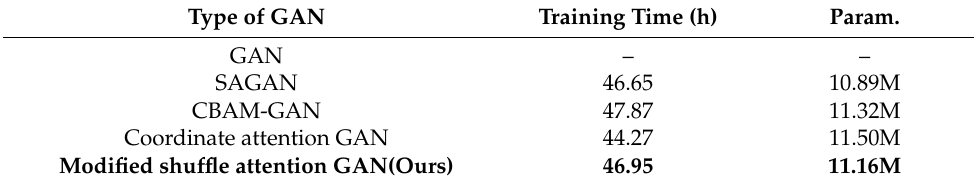
Table 3. Training time and network parameters (Param.) of different GAN models. Type of